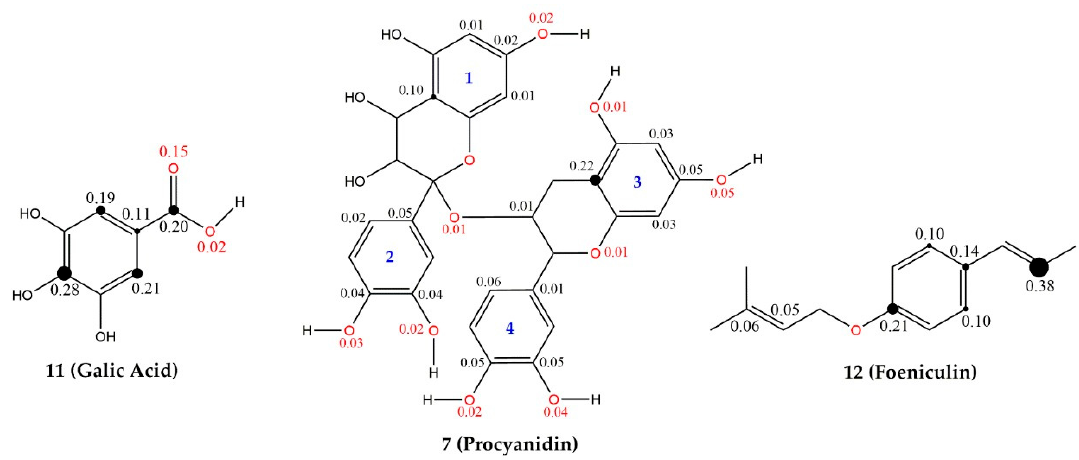
Figure 6. Spin densities in the cation free-radical of selected compounds.